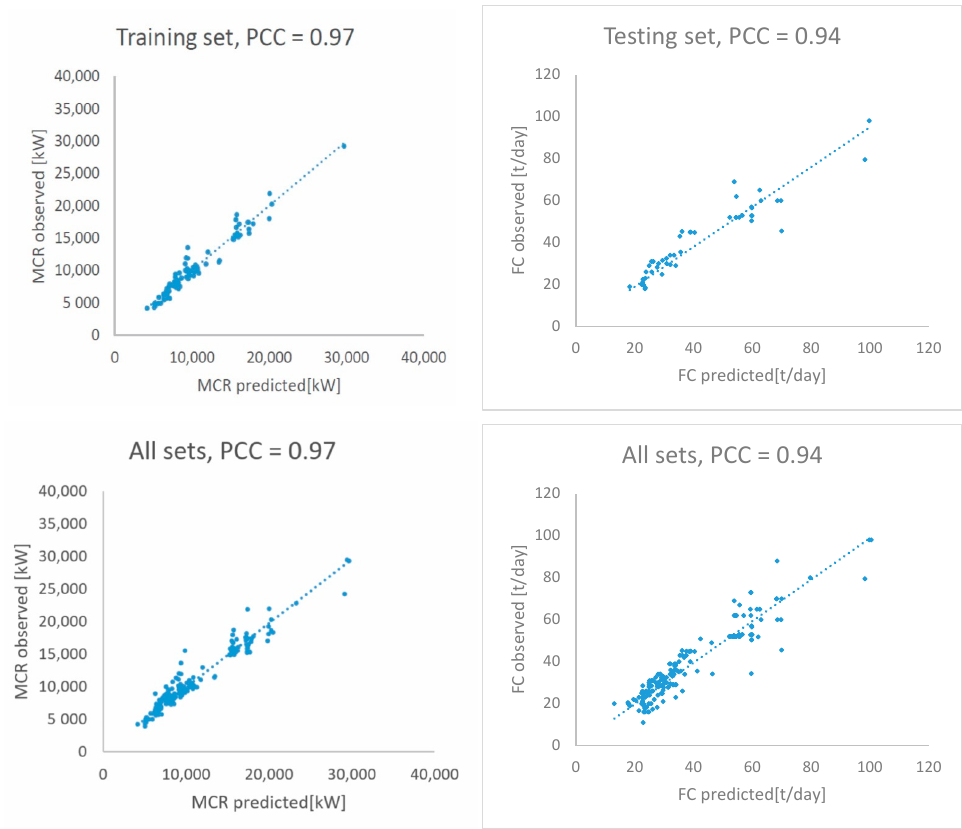
Figure 6. Regression graphs presenting the artificial neural network for estimating the engine power (MCR) and fuel consumption (FC) of bulk carriers.